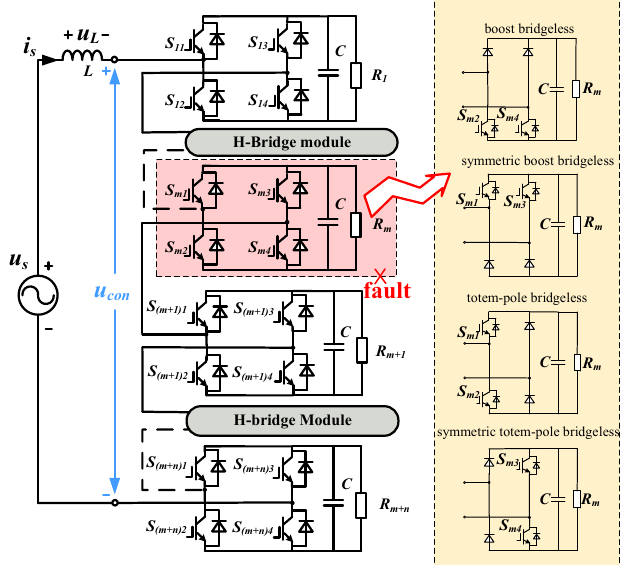
Figure 1. Topology of multifunctional cascaded H-bridge rectifier with its hybrid cascaded rectifier mode under open-circuit mode.